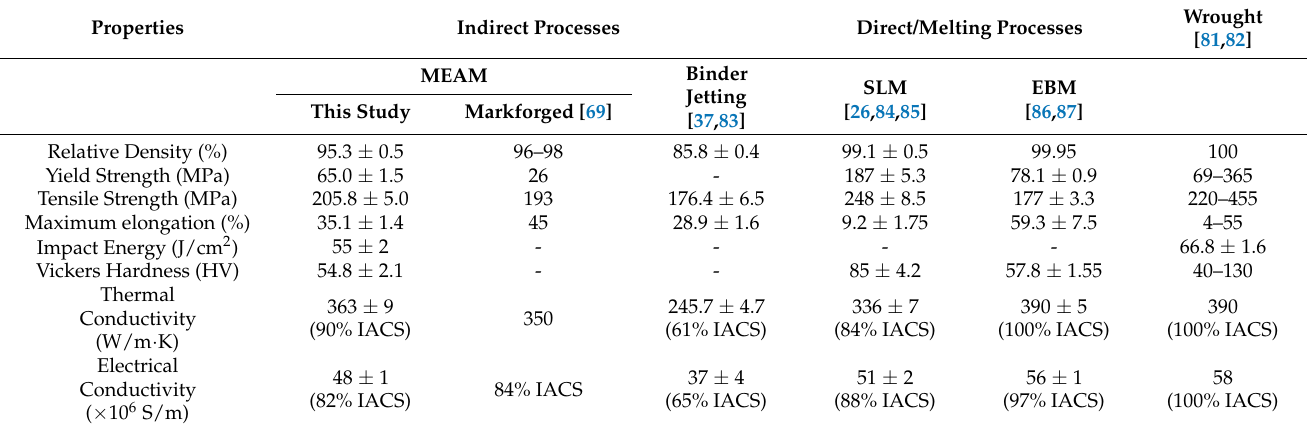
Table 3. Average values of mechanical, thermal, and electrical properties of copper parts manufac- tured by MEAM and comparison with other technology